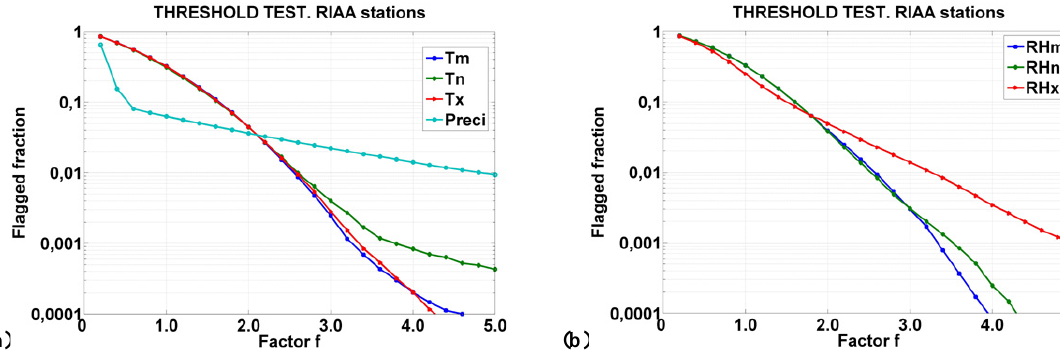
Figure 2. (a) Threshold Test – Maximum (Tx), minimum (Tn) and mean temperature (Tm) and Precipitation (Preci). (b) Threshold Test – Maximum (RHx), minimum (RHn) and mean relative humidity (RHm).